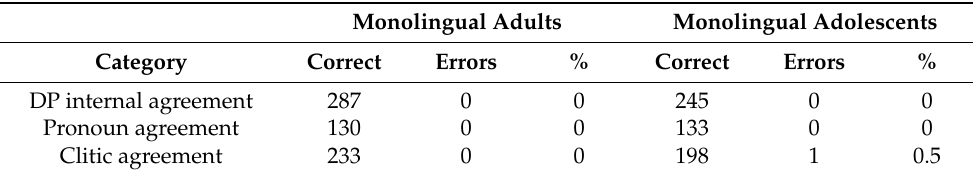
Table 6. Results. Greek monolingual controls, illustrating percentage of